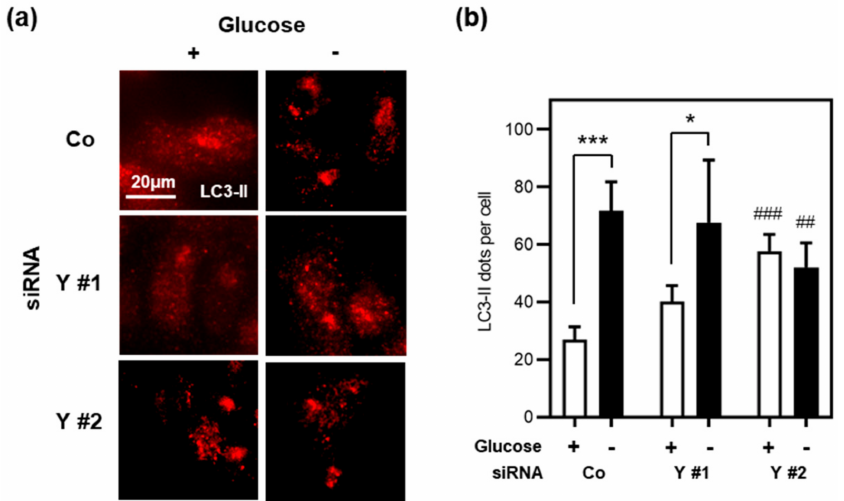
Figure 5. CCNY does not regulate autophagy in glucose-starved intestinal epithelial cells. ( a ) Im- munofluorescence analysis of endogenous autophagosome marker LC3-II in HCT116 cells upon cyclin Y loss-of-function by RNA interference. Cells were maintained for 16 h in complete media or glucose starvation media with 100 nM Bafilomycin A1. ( b ) The average number of LC3 dots per cell in panel ( a ) was quantified by computer-assisted image analysis ( n ≥ 6 images per condition, with ≥ 149 cells per image). Statistical analysis was performed using mixed-effects analysis (two-way ANOVA) followed by Dunnett’s post hoc test, and is presented as follows: * p < 0.05 and *** p < 0.001 versus complete media; ## p < 0.01 and ### p < 0.001 versus